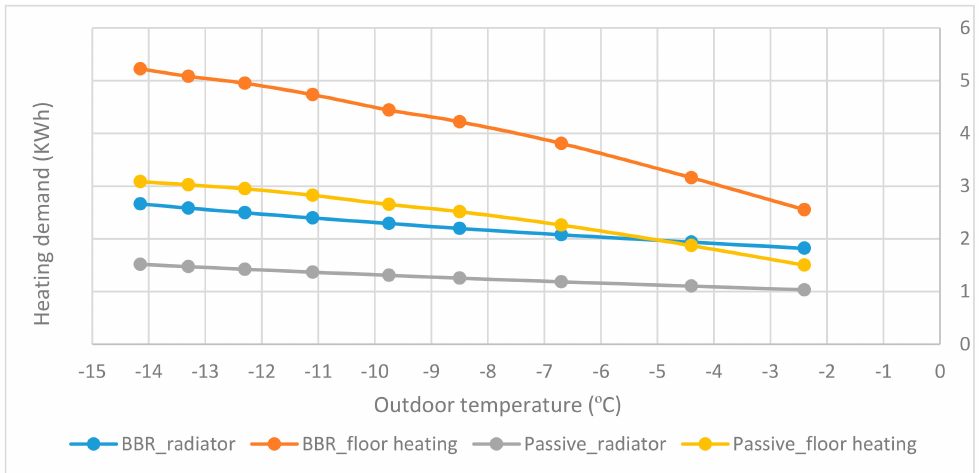
Figure 12. Supply heating demand changes versus outdoor temperatures for all studied reference models.